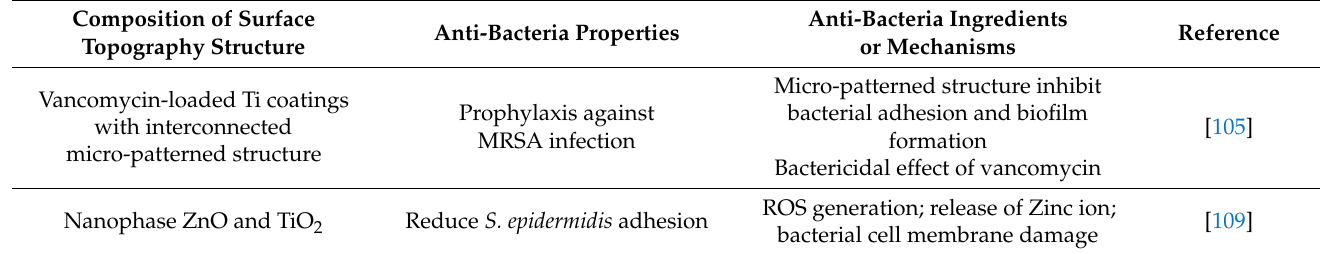
Figure 3. Immobilisation of polydopamine and hyaluronic acid on vancomycin-loaded titanium nanotube. Ti-NT bio-functionalized with polydopamine and hyaluronic acid to overcome the limitations of Ti-NT via improving drug loading, antibacterial activity, and osteogenic ability. It exhibited better antibacterial ability and promoted the osteogenic differentiation of rat bone marrow stem cells. Reprinted with permission from ref. [119]. Copyright 2022 Elsevier. Table 3. Composition and antibacterial mechanism of surface topography